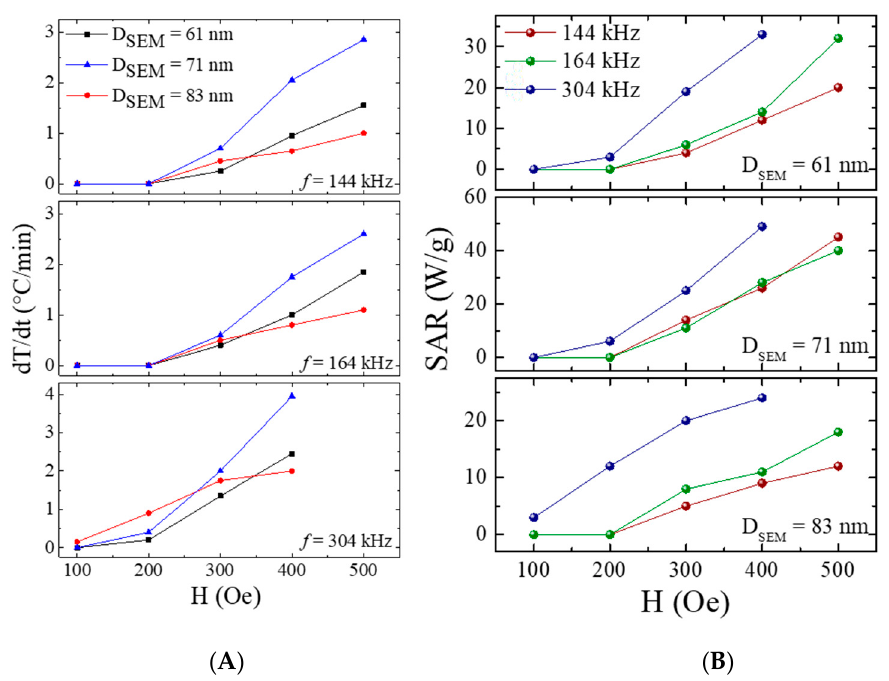
Figure 4. The effect of changing applied A.C. magnetic fields (H) at different frequencies f for samples with morphological sizes 61, 71, 83 nm on ( A ) the temperature and ( B ) S.A.R.